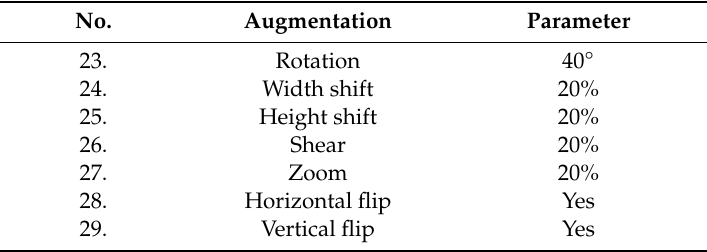
Table 2. Augmentation parameters [26].